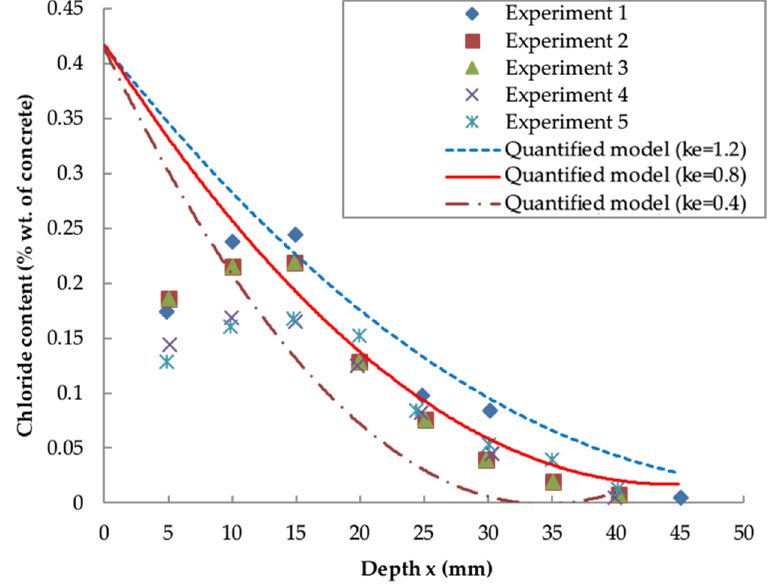
Figure 6. Comparison between experimental results and quantified models.